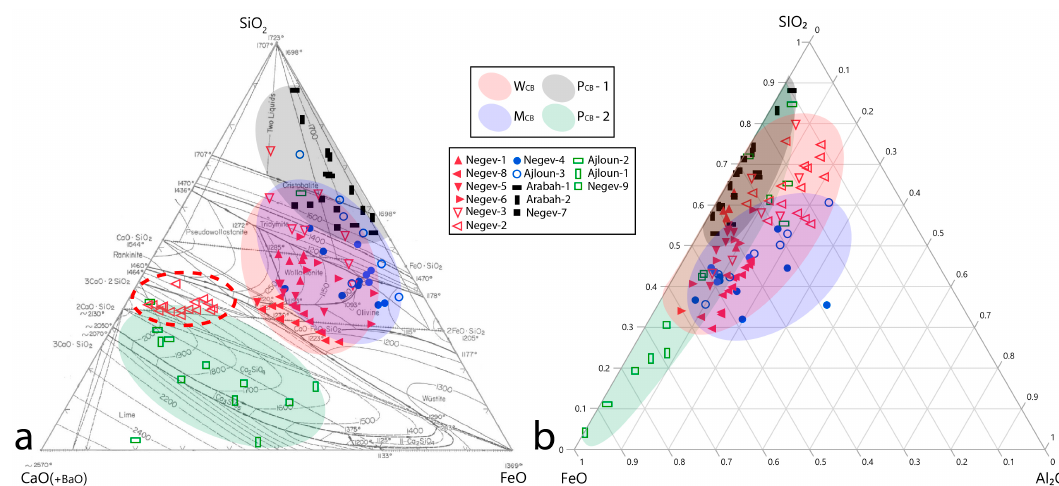
Figure 8. Bulk-area analyses of slag, as plotted on the ternary diagrams: ( a ) CaO (+BaO)–FeO–SiO 2 ; with solidus lines, after Figure 586 in reference [32]; ( b ) Al 2 O 3 –FeO–SiO 2 . Each dot represents one bulk-area analysis. Ellipses represent domains of all slags attributed to W CB (red), M CB (blue), P CB -type 1 (grey), and P CB -type 2 (green) groups. Red dotted area designates sample outlier (Negev-2) of a group W CB . P CB -type 1 domain represents analyses of the slag-rich areas including porphyritic quartz